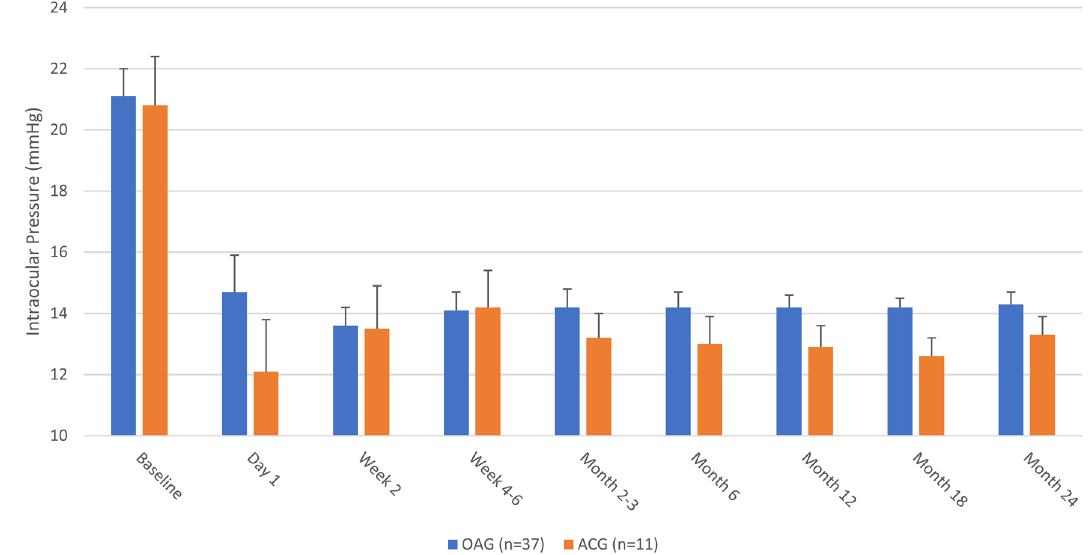
Figure 1. Mean IOP at each visit in eyes with open-angle glaucoma (n = 37) and angle-closure glaucoma (n = 11). In eyes with OAG, p ≤ 0.0001 at all time points; in eyes with ACG, p ≤ 0.0353 at all time points. Error bars represent standard error.